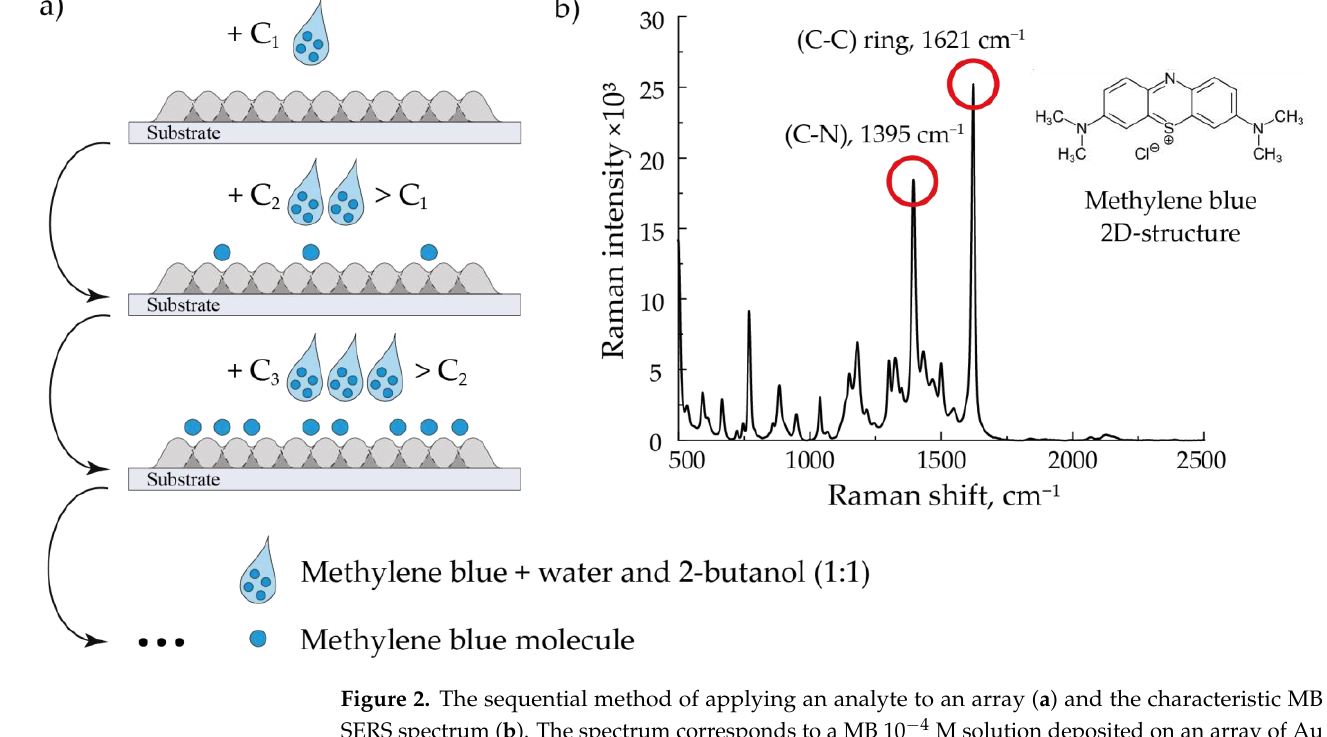
Figure 2. The sequential method of applying an analyte to an array (on the left) and the characteristic MB SERS spectrum (on the right). The spectrum corresponds to a MB 10 − 4 M solution deposited on SERS spectrum ( b ). The spectrum corresponds to a MB 10 − 4 M solution deposited on an array of Au an array of Au NPs modified by laser radiation at a flow rate of 400 mL/min. NPs modified by laser radiation at a flow rate of 400